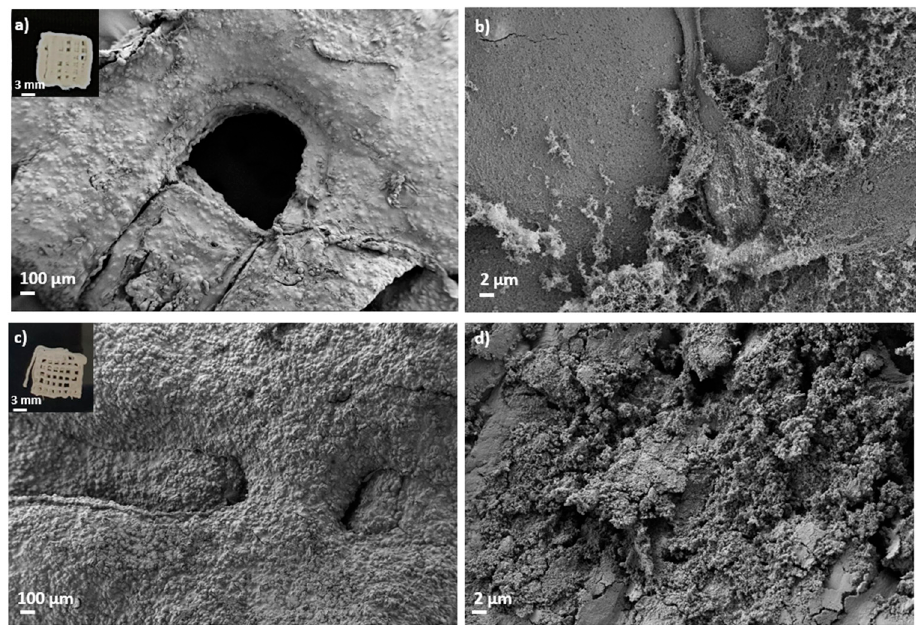
Figure 3. SEM images of 3D-printed and aged aerogel scaffolds prepared from alginate 6 wt.% and HA 16 wt.% inks ( c , d ) with and ( a , b ) without GA post-crosslinking step. All formulations were crosslinked with GA vapor. Aerogels were observed at two different magnifications. Intake in ( a , c ): visual appearance of the aerogel scaffolds with a well-defined 3D-pattern. Table 2. Textural properties of aerogel-based scaffolds obtained from aqueous 6 wt.% alginate inks with different HA concentrations (0, 8, 16, 24 wt.%) and crosslinked by different strategies: CaCl 2